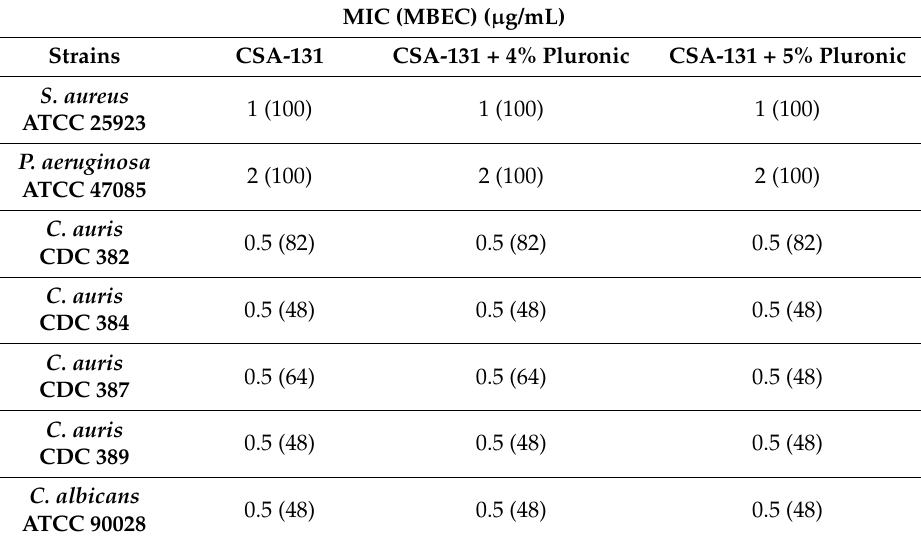
Table 1. Minimum inhibitory concentration (MIC) and minimum biofilm eradication concentration (MBEC) of CSA-131 with bacteria and fungi in the absence or presence of